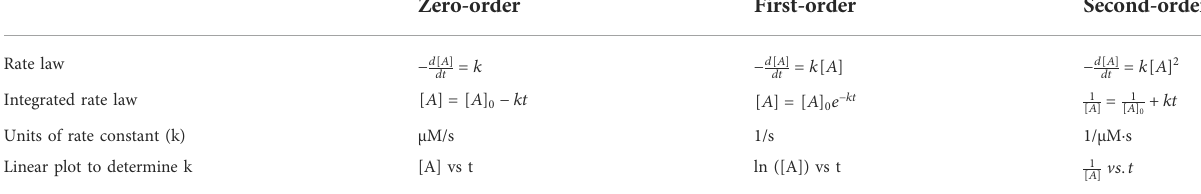
TABLE 1 Kinetics rate